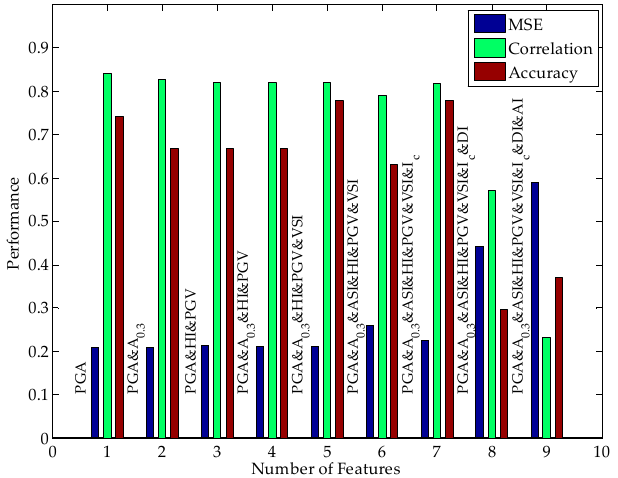
Figure 7. Performance of best SVRs with 1 – 9 features.